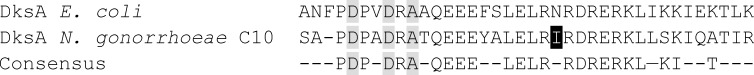
Mutations identified in N. gonorrhoeae grown with sub-lethal monocaprin.An alignment of a portion of DksA from E. coli (DksA E. coli) and the monocaprin culture mutation of N. gonorrhoeae (DksA N. gonorrhoeae C10). The grey highlighting indicates residues important in RNA polymerase binding in E. coli, conserved in N. gonorrhoeae. The black highlight indicates the mutation in N. gonorrhoeae grown with sub-lethal monocaprin.